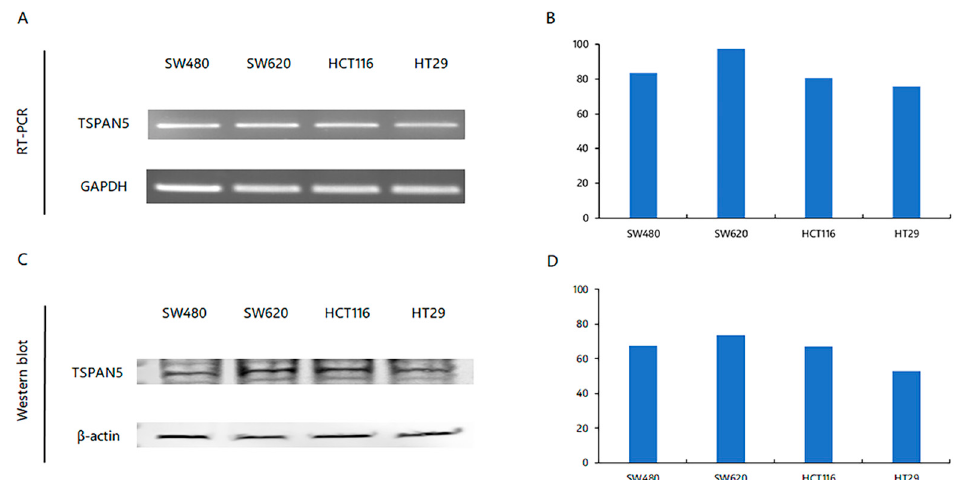
Figure 1. Expression of TSPAN5 in colorectal cancer cell lines. ( A ) Confirmation of TSPAN5 expression in cell lines determined using RT-PCR. ( B ) Graph of relative TSPAN5 mRNA expression level in cell lines determined using RT-PCR. ( C ) Confirmation of TSPAN5 expression of cell lines determined using western blotting. ( D ) Relative TSPAN5 protein expression in cell lines was determined using Western blotting.